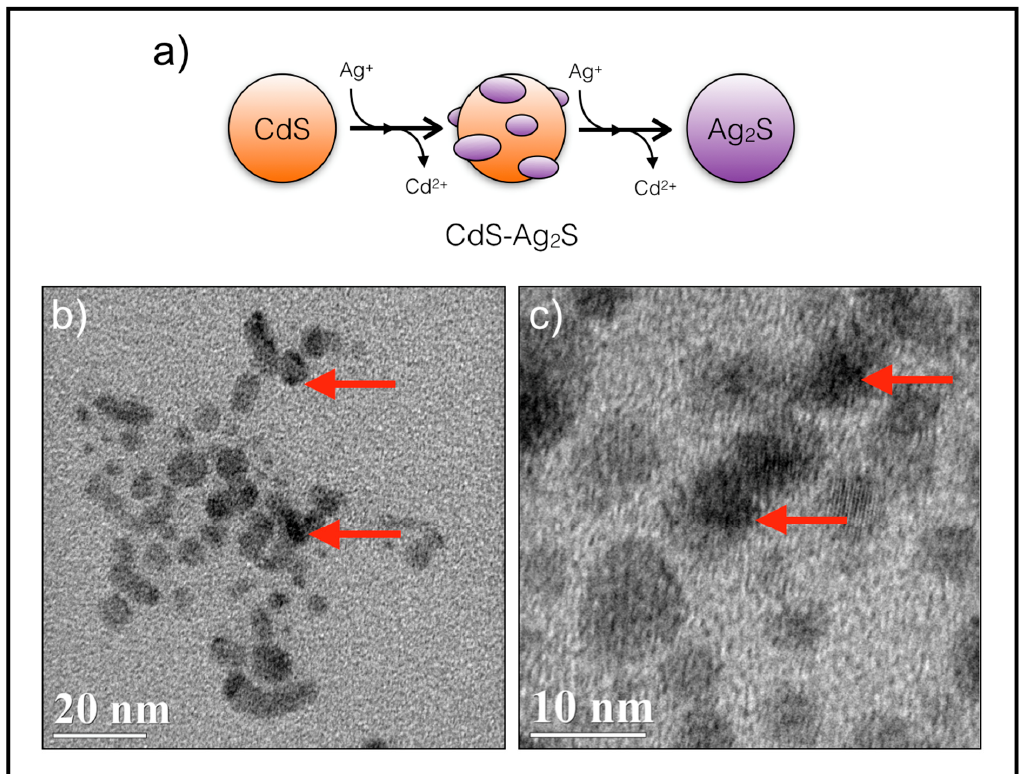
Figure 5. HR-TEM analysis of CdSAg biosynthesized nanoparticles. ( a ) Scheme of the formation of binary (CdS, Ag 2 S) and ternary (CdSAg) quantum dots by cation exchange. ( b ) and ( c ) Purified CdSAg NPs. Arrows indicate electrodense zones present in the ternary nanostructure.